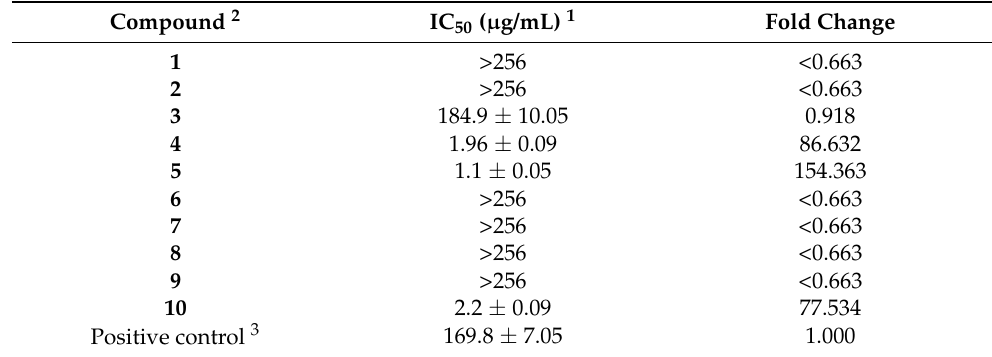
Table 2. Half-maximal inhibitory concentration (IC 50 ) for inhibition of α -glucosidase by the isolated compounds from Millettia speciosa